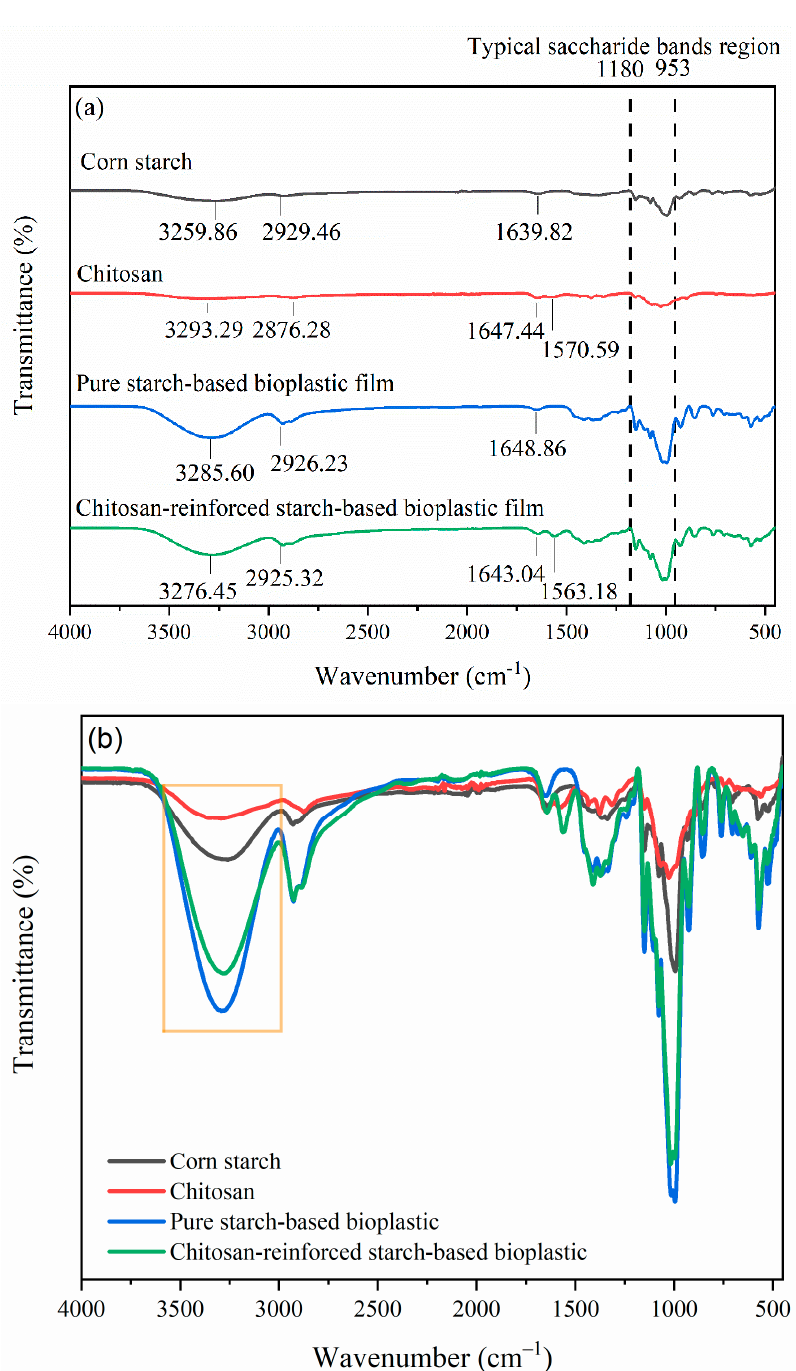
Figure 10. ( a ) FTIR spectra and ( b ) overlapping FTIR spectra of corn starch, chitosan powders, pure starch-based and chitosan-reinforced starch-based bioplastic films.